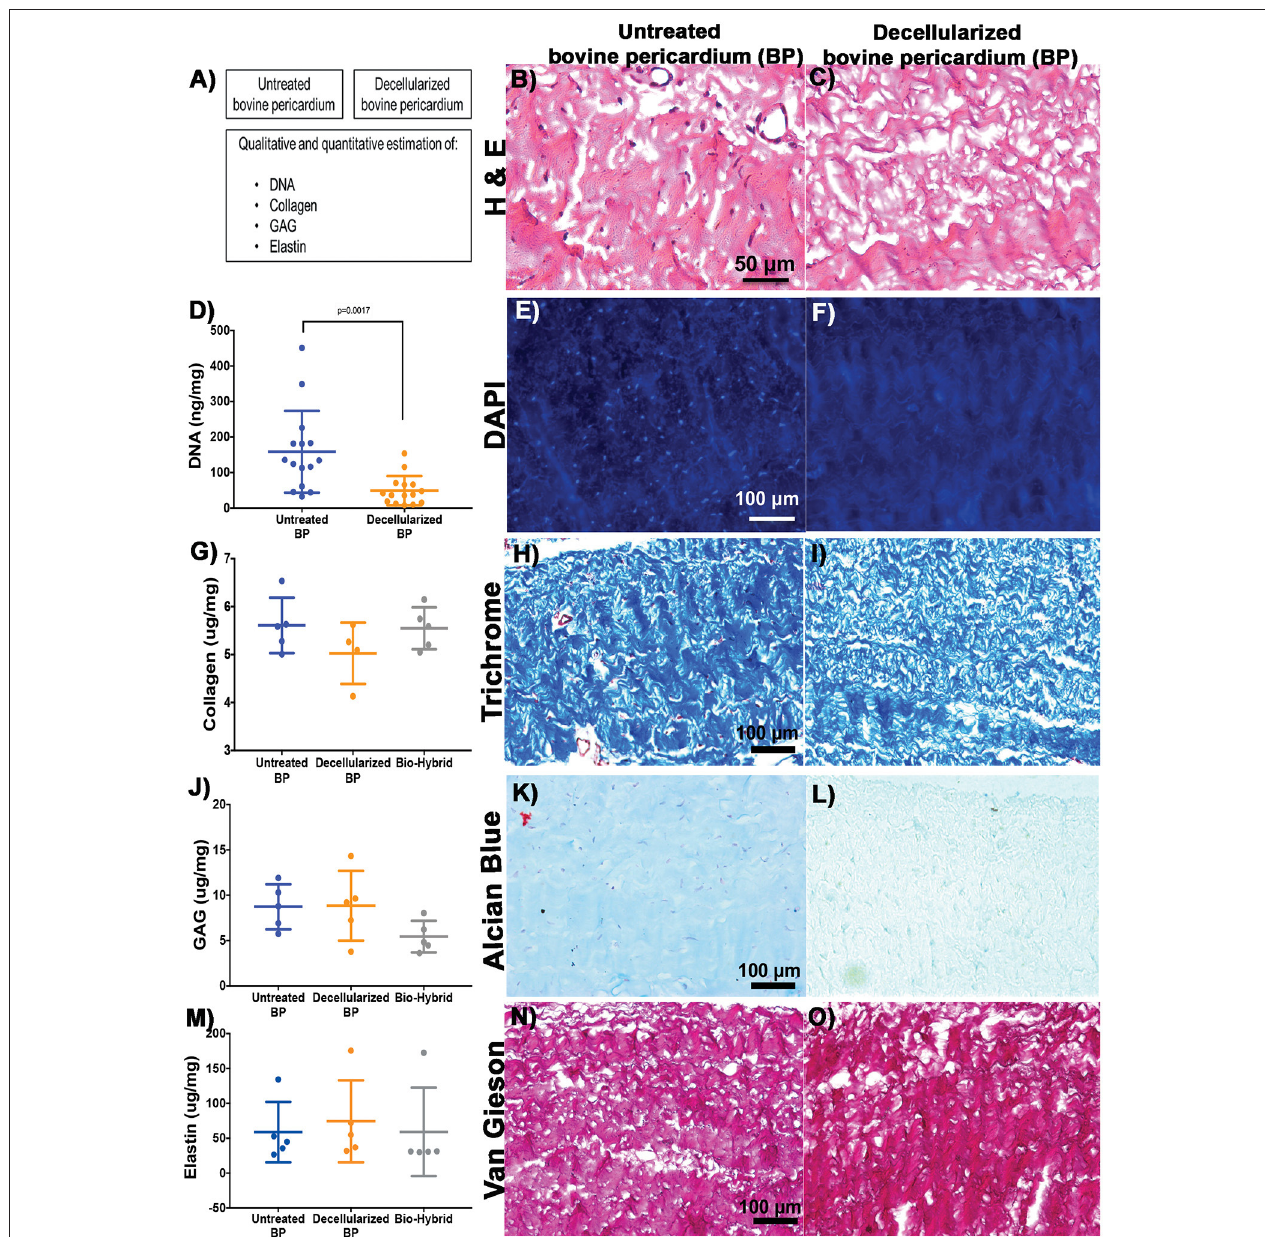
FIGURE 2 | Characterization of the untreated BP and decellularized BP by using histopathology and biological estimation of extracellular matrix proteins. (A–C) Schematic representation of the characterization and H&E staining showing absence of cells in the decellularized BP. (D–F) Quantification of total DNA showing significant reduction in the decellularized BP and 4,6-diamidino-2-phenylindole (DAPI) staining showing absence of DNA in the decellularized BP. (G–I) Quantification of collagen showing no reduction of collagen in the decellularized BP and the biohybrid and trichrome staining showing presence of collagen represented by blue color in the decellularized BP. (J–L) Quantification of glycosaminoglycans (GAGs) showing no significant reduction of GAGs in the decellularized BP and the biohybrid and Alcian blue staining showing presence of GAG represented by cyan color in the decellularized BP. (M–O) Quantification of elastin showing no significant reduction of GAGs in the decellularized BP and the biohybrid and Verhoeff’s Van Gieson staining showing presence of elastin represented by black fibers in the decellularized BP.